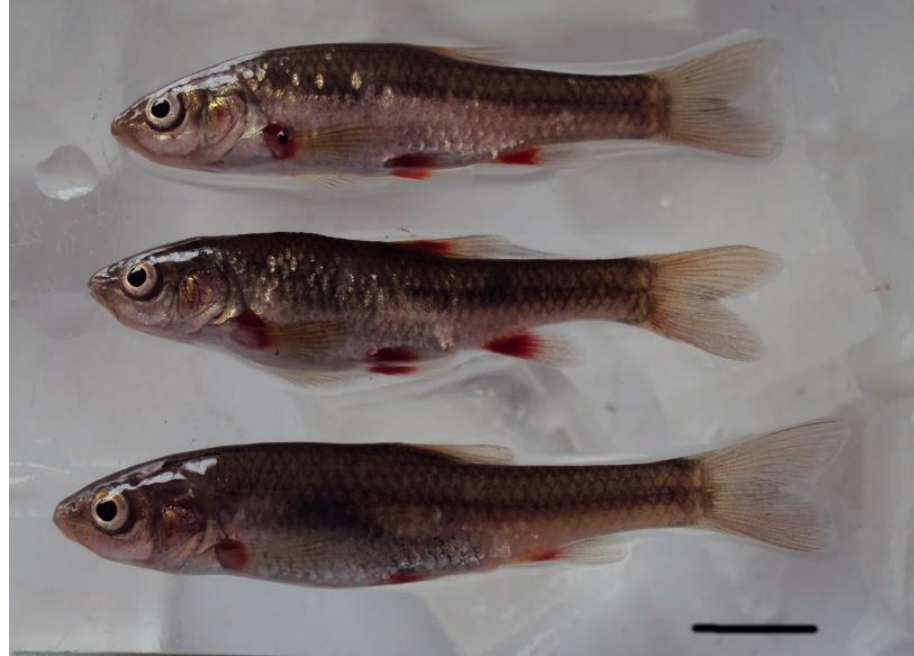
Figure 1. Three examples of Pseudobarbus afer specimens. The scale bar = 10 mm. Redfins were collected using a dip net from pools in a 2 km stretch of the Klein Uie River (Le Roux farm; 33 ◦ 19.825 (cid:48) S, 25 ◦ 29.456 (cid:48) E). The fish were maintained for 1 month to acclimate to experimental conditions, during which they were fed once or twice per day on tropical flake fish food. Seven 1 m diameter pools were constructed from 500 µ m black PVC plastic supported by 30 cm high corrugated plastic sides. Each pool contained a 3 cm thick layer of cleaned sand and 80 l of river water. A domed, semi-circular enclosure, approximately 2 m tall at the highest point, was constructed, using off-white PVC plastic piping and green shade cloth, and placed over the pools. The enclosure was open at each end, allowing air to flow through, while the shade cloth roof mimicked overhanging riparian vegetation (Figure 2). This enabled us to maintain natural environmental conditions as much as